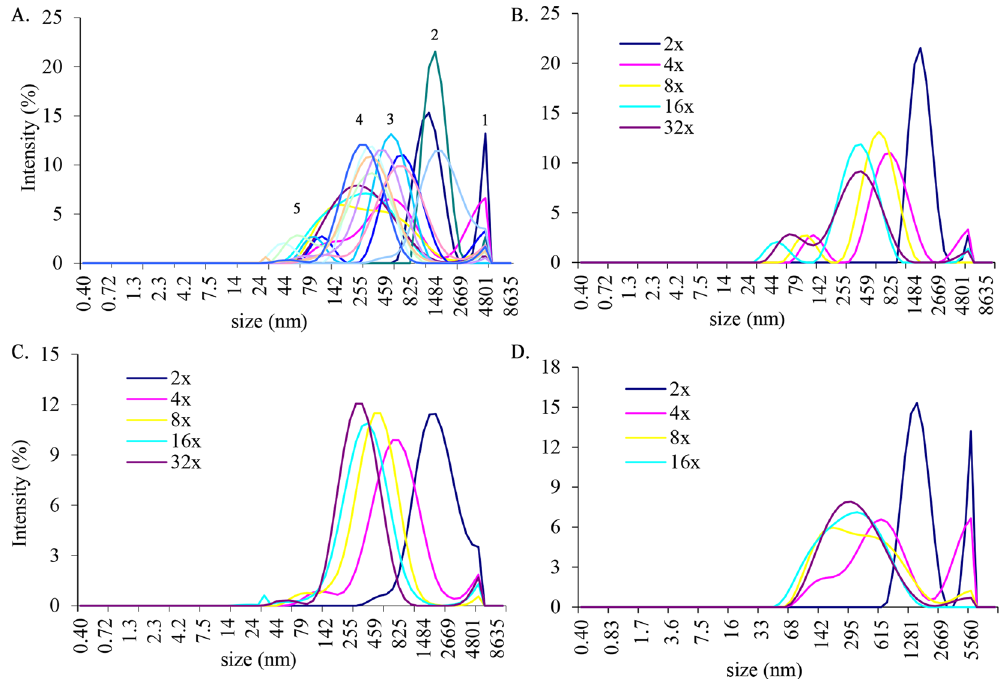
Figure 2. The particle size distribution by intensity in all honeys as a function of dilution in 2-fold to 32-fold range ( A ). The distribution of particle sizes in medium (H207) ( B ), light (H212) ( C ) and dark honey (H220) honey ( D ) as a function of